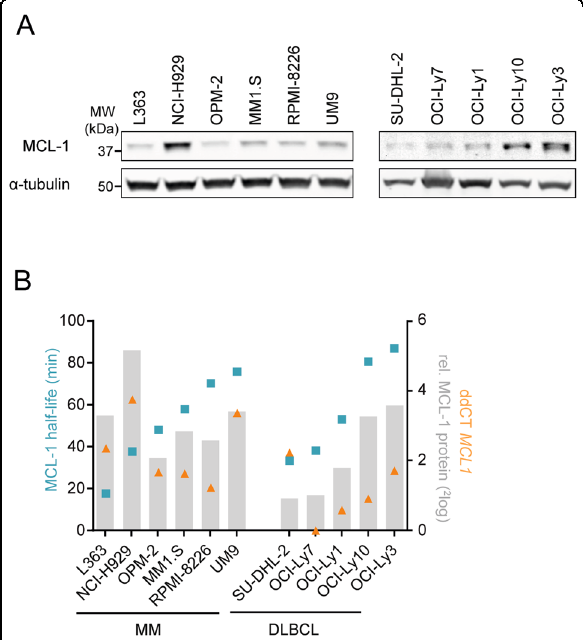
Fig. 2 MCL-1 protein level re fl ects transcriptional activity as well as protein half-life. A MCL-1 protein expression in the MM and DLBCL cell line panel. B Relative MCL-1 protein expression (over α - tubulin) in the MM and DLBCL cell line panel as determined by immunoblotting (gray bars, right y -axis), compared to MCL-1 protein half-life (blue squares, left y -axis) and MCL1 gene expression as determined by RT-PCR (orange triangles, right y -axis). MCL-1 gene and protein expression values are averages of two experiments. MCL-1 half-lives are averages of 3 – 6 independent replicates per cell line as outlined per cell line for Fig.